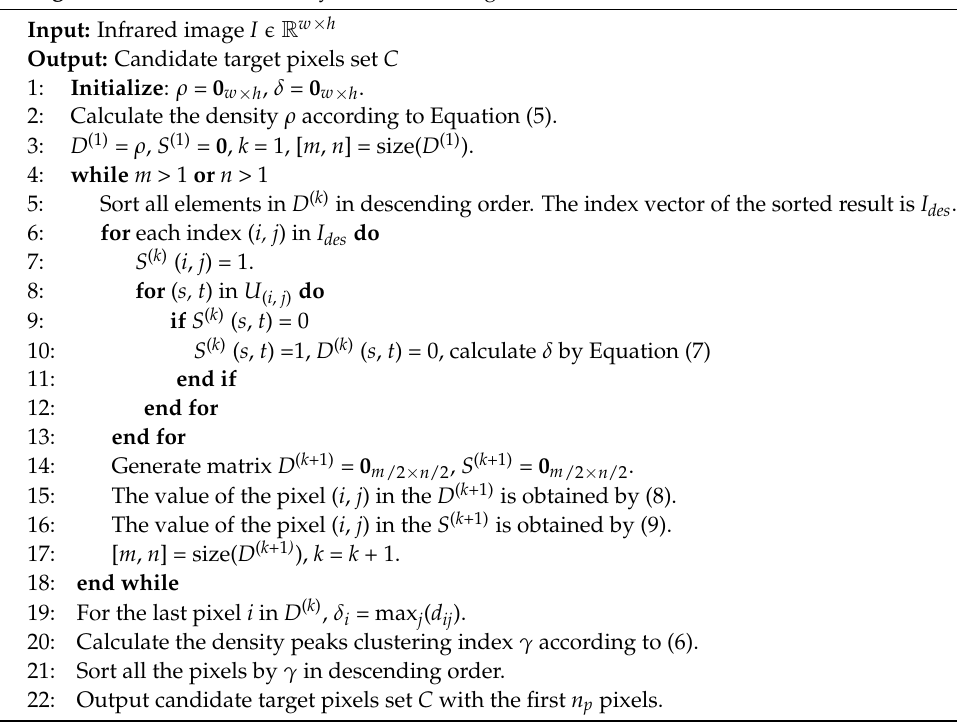
Algorithm 1 Modified Density Peaks